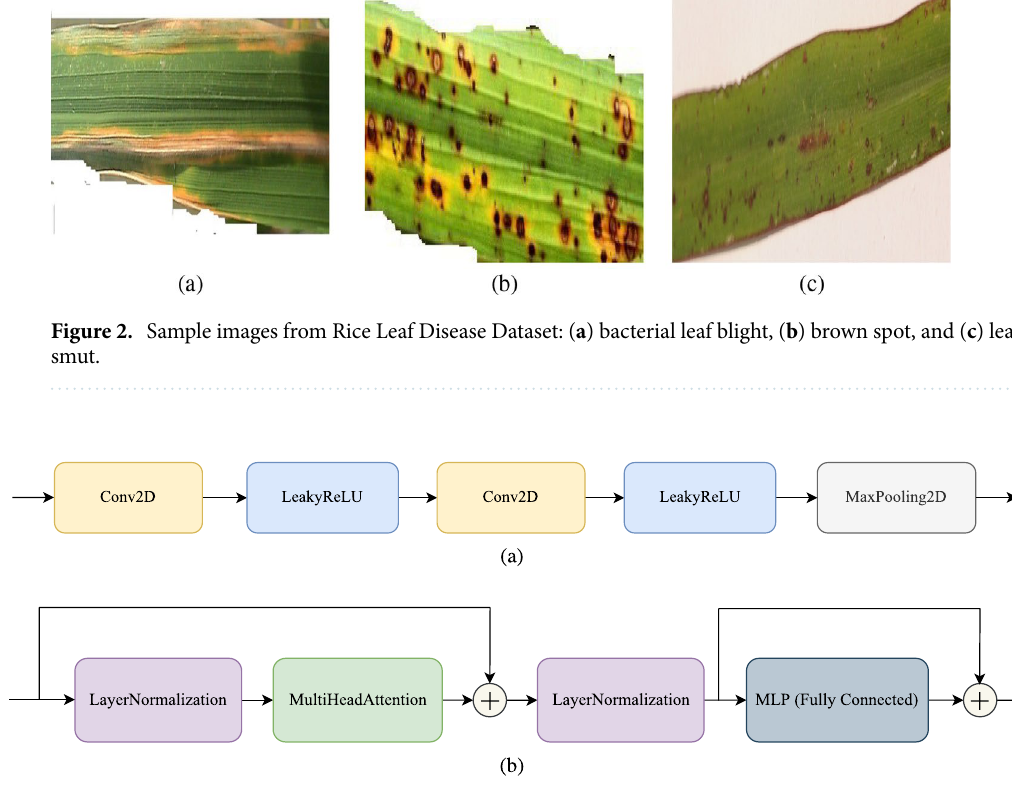
Figure 3. The schematics of the ( a ) convolutional block structure and ( b ) transformer block